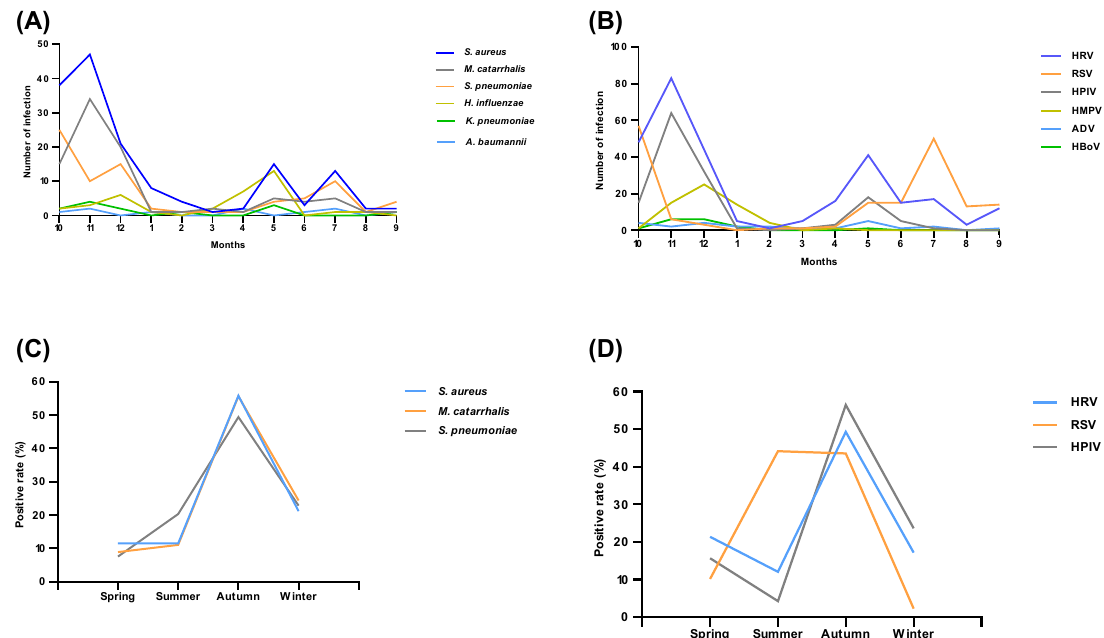
Figure1: MonthlyandseasonaldistributionofrespiratorypathogensfromOctober2020toOctober2021(A)monthlydistributionofbacteria(B)monthly distribution of virus (C) seasonal distribution of mainly infected bacteria (D) seasonal distribution of mainly infected